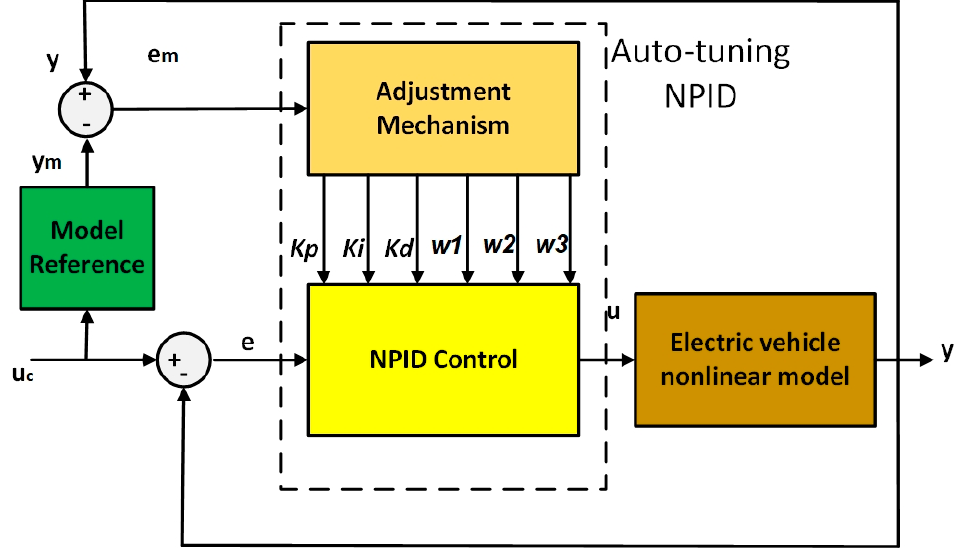
Figure 4. The overall system with self-tuning NPID is based on the model reference technique. The nonlinear gain 𝐾 (cid:3041) (𝑒) is lower-bounded by 𝐾 (cid:3041) (𝑒) min = 1 when e = 0, and upper- bounded by 𝐾 (cid:3041) (𝑒) max = ch( 𝑤 (cid:3036) 𝑒 (cid:3040)(cid:3028)(cid:3051) ). Therefore, 𝑒 (cid:3040)(cid:3028)(cid:3051) stands for the range of deviation, and 𝑤 (cid:3036) describes the rate of variation of 𝐾 (cid:3041) (𝑒) .